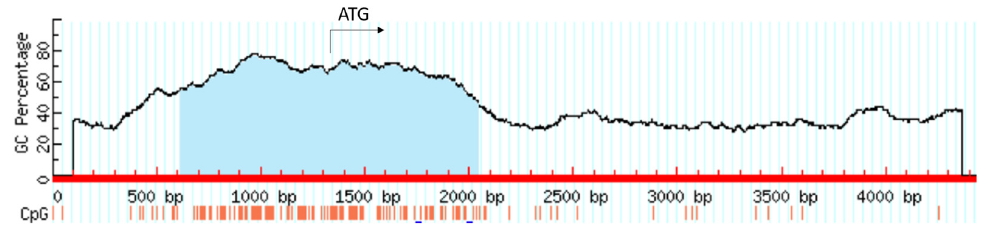
Figure 7. CpG island comprising 1431 bp associated with the HIF1A